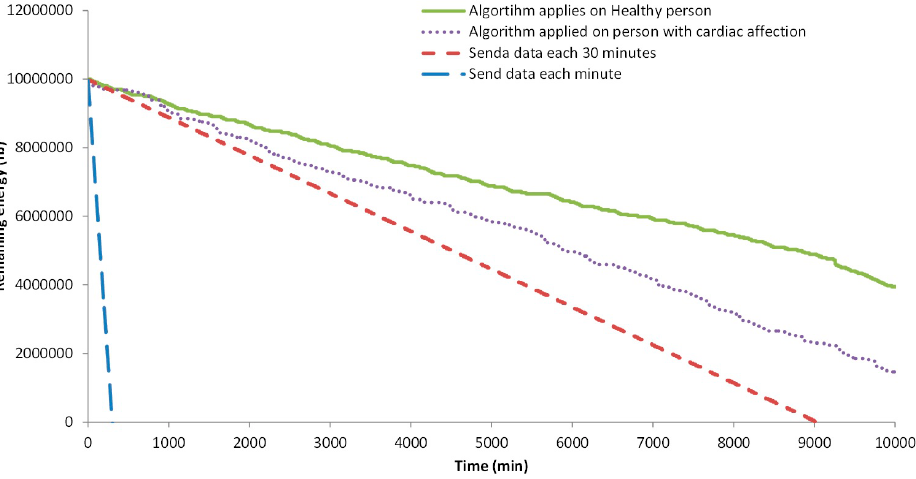
Figure 8. Generated traffic by a 4-member family.